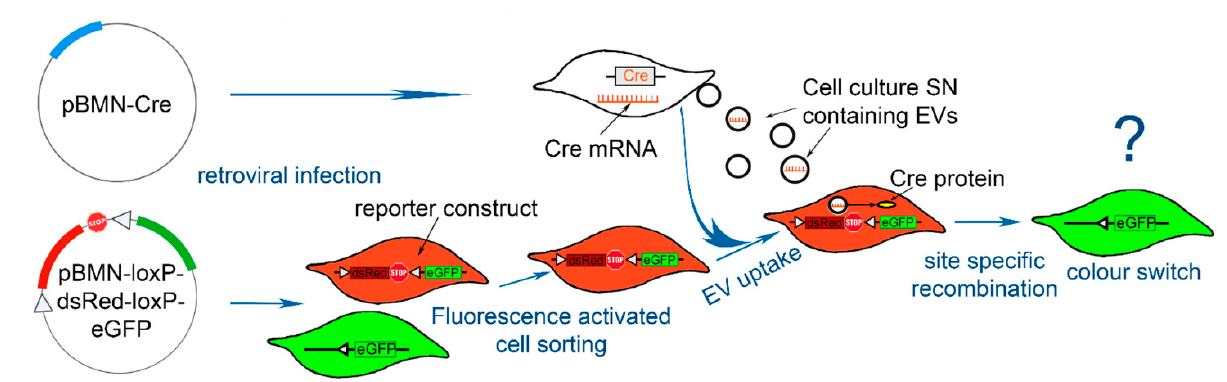
Figure 1. Scheme of the strategy applying the adapted Cre-loxP system for extracellular vesicle (EV) uptake evaluation. The plasmids encoding for the Cre recombinase and the reporter construct were retrovirally transduced into the cells (human umbilical vein endothelial cell (HUVEC), human induced pluripotent stem cell derived endothelial colony forming cell (hiPSC-ECFC), and adipose tissue-derived mesenchymal stromal/stem cell (ASC)). Reporter cells expressing the complete reporter construct (red) consisting of a floxed dsRed cDNA and a stop codon upstream of an eGFP cDNA were sorted by fluorescence activated cell sorting (FACS) for dsRed expression. Cre expressing cells (white, Cre + ) are producing EVs containing Cre mRNA, which is introduced into the reporter cells via EV uptake. Due to site specific recombination the floxed part of the reporter construct is deleted and a color switch to eGFP (green) is detectable.